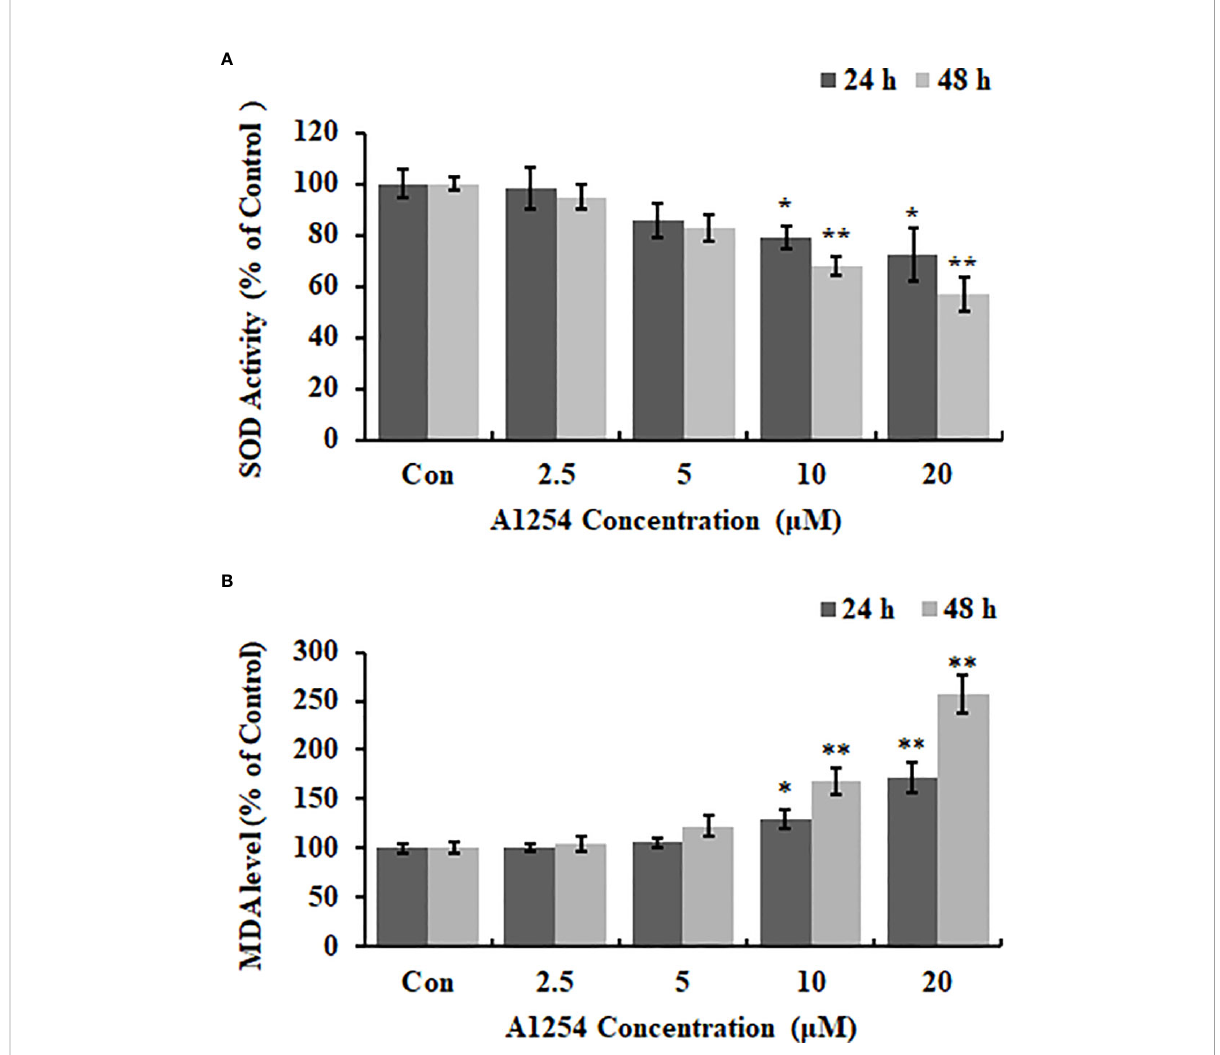
FIGURE 2 The SOD activity and MDA content after A1254 exposure. MC3T3-E1 were exposed to various doses of A1254 for 24 or 48h as described above. (A) SOD activity and (B) MDA content after A1254 exposure were detected using a SOD detection kit and MDA assay kit, respectively. Data derived from three independent experiments with 3 repeats for each group. *p<0.05, **p<0.01 compared to